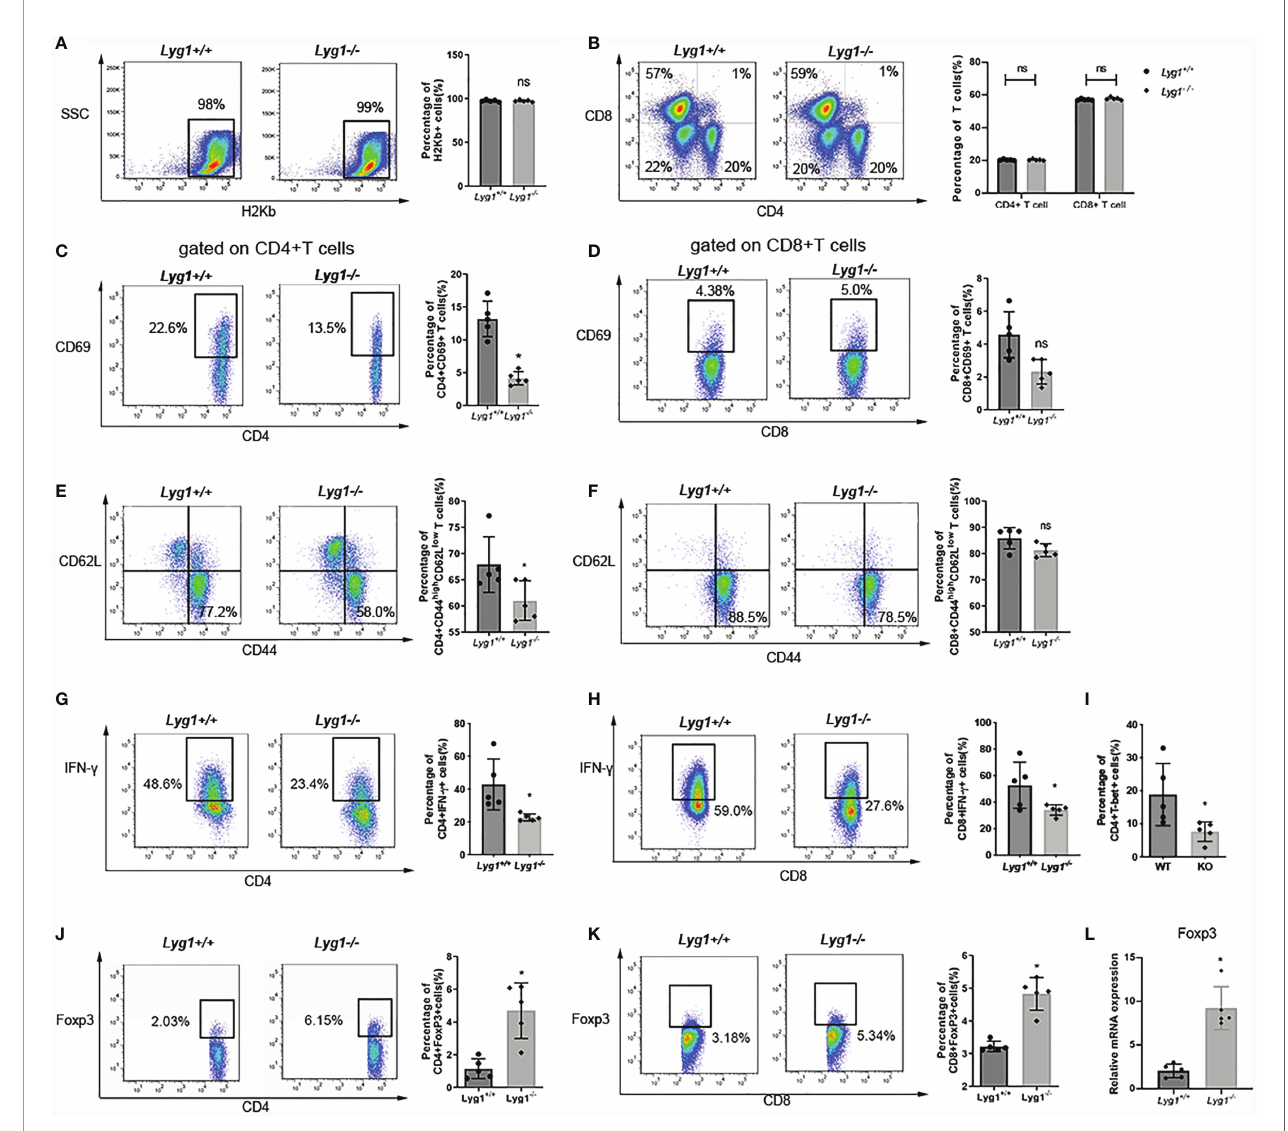
FIGURE 3 | LYG1 de fi ciency reduced allogeneic T cells function in spleens. Splenocytes of recipient mice were isolated on day 7 after transplantation and analyzed by fl ow cytometry and qPCR. (A) The percentages of H2Kb+ cells in living splenocytes. (B) The percentages of CD4 + T and CD8 + T cells in H2Kb+ splenocytes. (C, D) The percentages of CD69 expression in CD4 + T cells and CD8 + T cells. (E, F) The expression of effector (CD44 hi CD62L lo ) phenotype gated on CD4 + T and CD8 + T cells. (G, H) The percentages of IFN- g expression in CD4 + T cells and CD8 + T cells. (I) The percentages of T-bet expression in CD4 + T cells. (J, K) The percentages of Treg in CD4 + T cells and CD8 + T cells. The percentages of Figure 3 (C – K) were all gated on H2Kb + CD4 + cells or H2Kb + CD8 + cells. (L) Foxp3 expression of splenocytes were examined by qPCR. Independent experiment was performed 3 times. The results in the repeats were similar. n = 5 per group. Representative plots are shown and statistical results are expressed as the mean ± SD, *p < 0.05 compared with Lyg1 +/+ group. ns, no signi fi